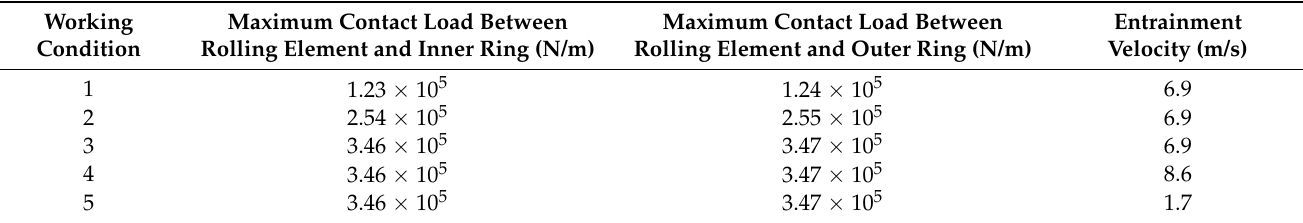
Table 3. Results of pseudo-statics calculation.